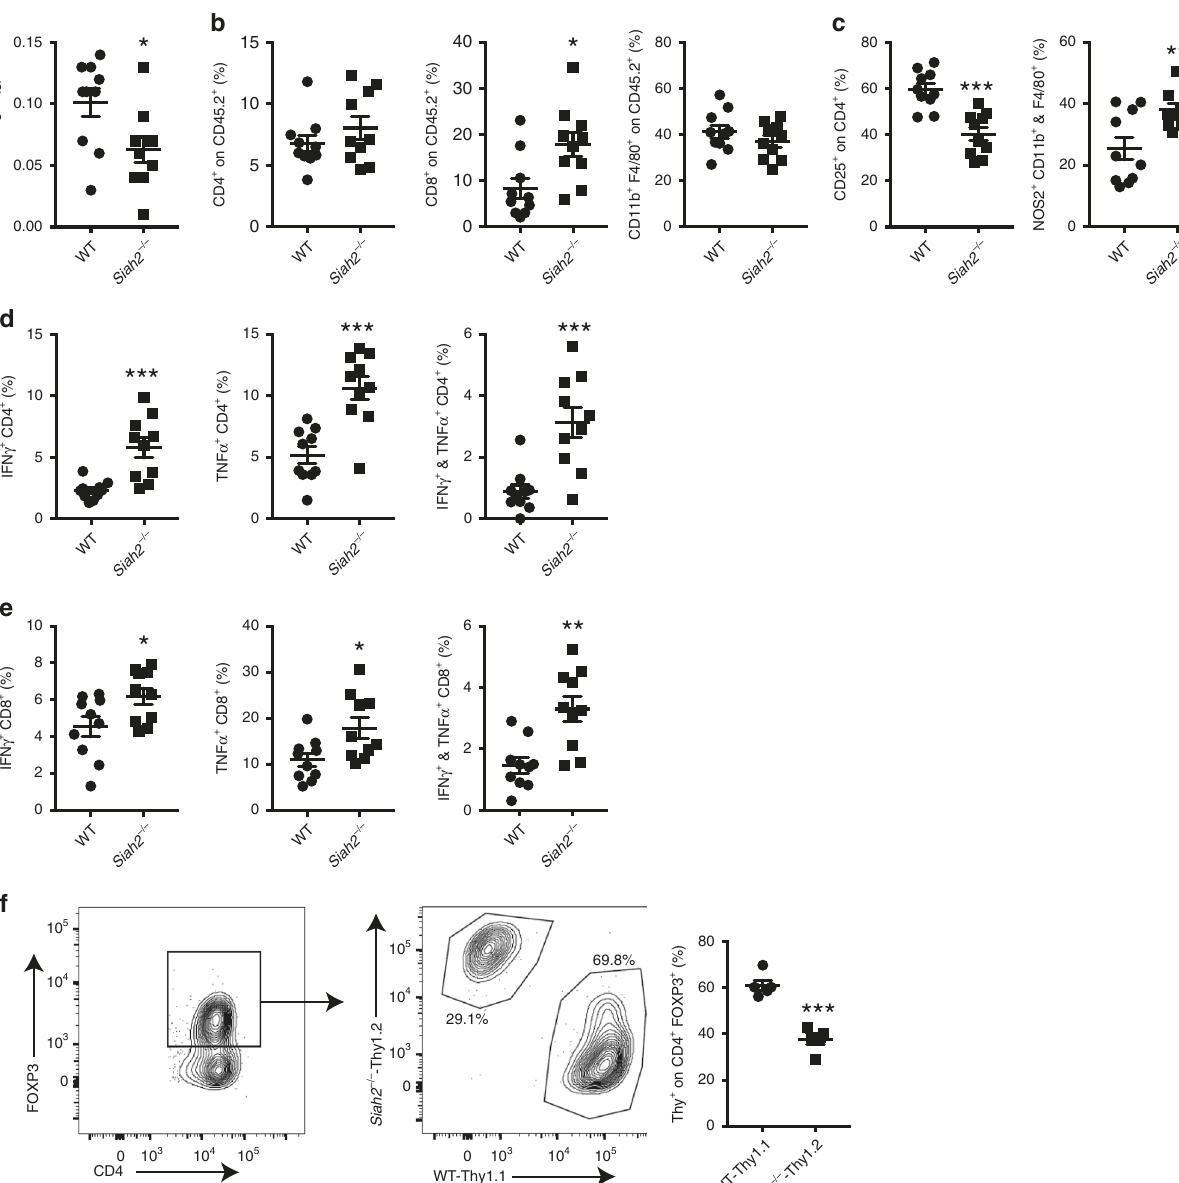
cycle-related genes identi fi ed decreased expression of E2F1 targets, including Dnmt1 , within the Treg cluster (Fig. 4e, Supplementary Fig. 4f, Supplementary Table 3), a change observed in most immune cell clusters obtained from tumors grown in Siah2 − / − mice (Supplementary Fig. 4g).